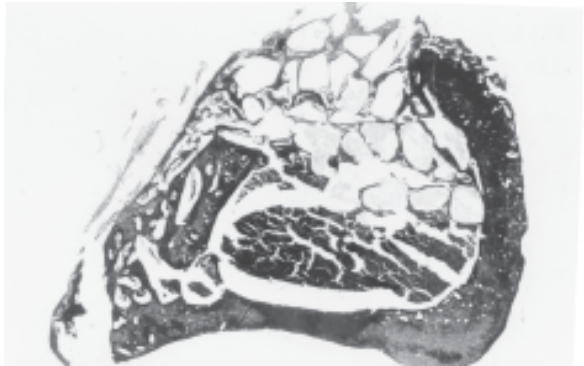
FIGURE 1 - Biogran (BG) 7 days. Spaces taken up by glass particles of varying sizes (A); thin bone trabeculae, some of them with lamellar aspect and marrow tissue. Some spaces are subdivided by thin bone septa, new bone formation next to defect margins (B), facing the periosteum and the inner part of the marrow space. Mallory trichrome.